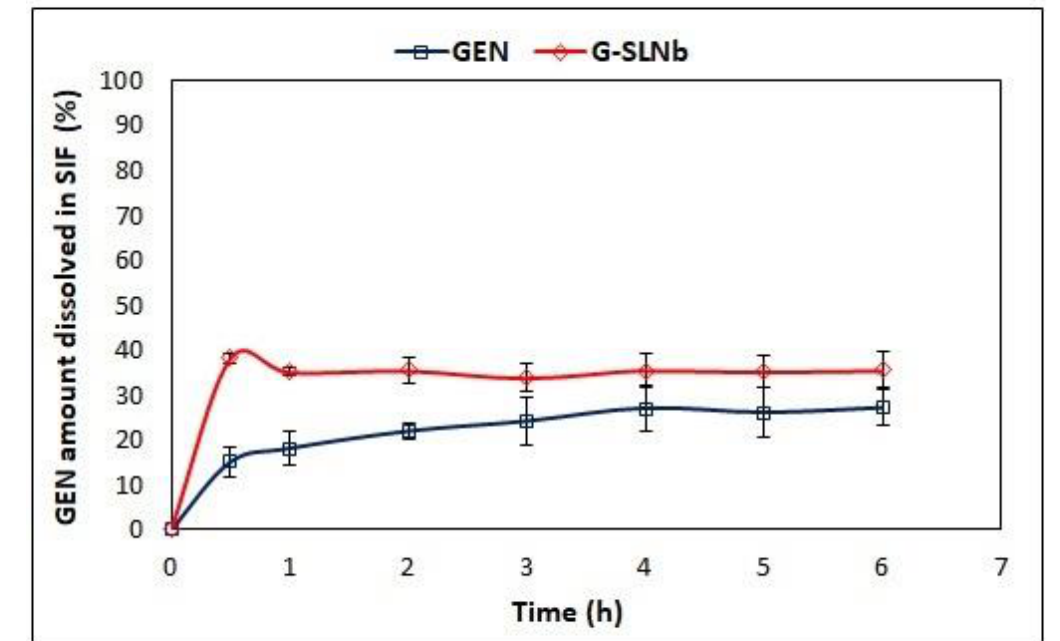
Figure 4. In vitro GEN release profile from G-SLNb and the dissolution profile of GEN. Data are reported as mean ± SD ( n = 3).